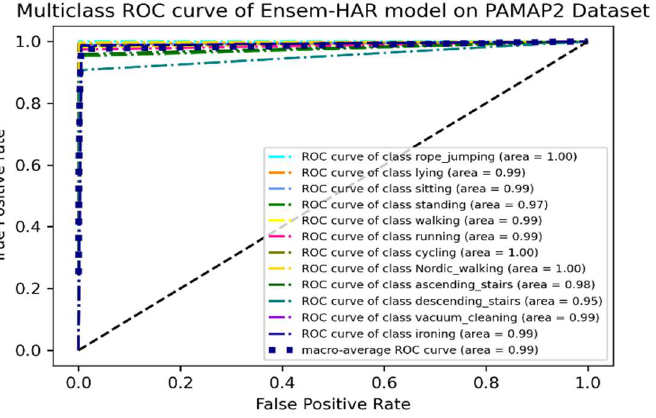
Figure 17. ROC curve (one vs. rest) of the proposed Ensem-HAR model on the PAMAP2